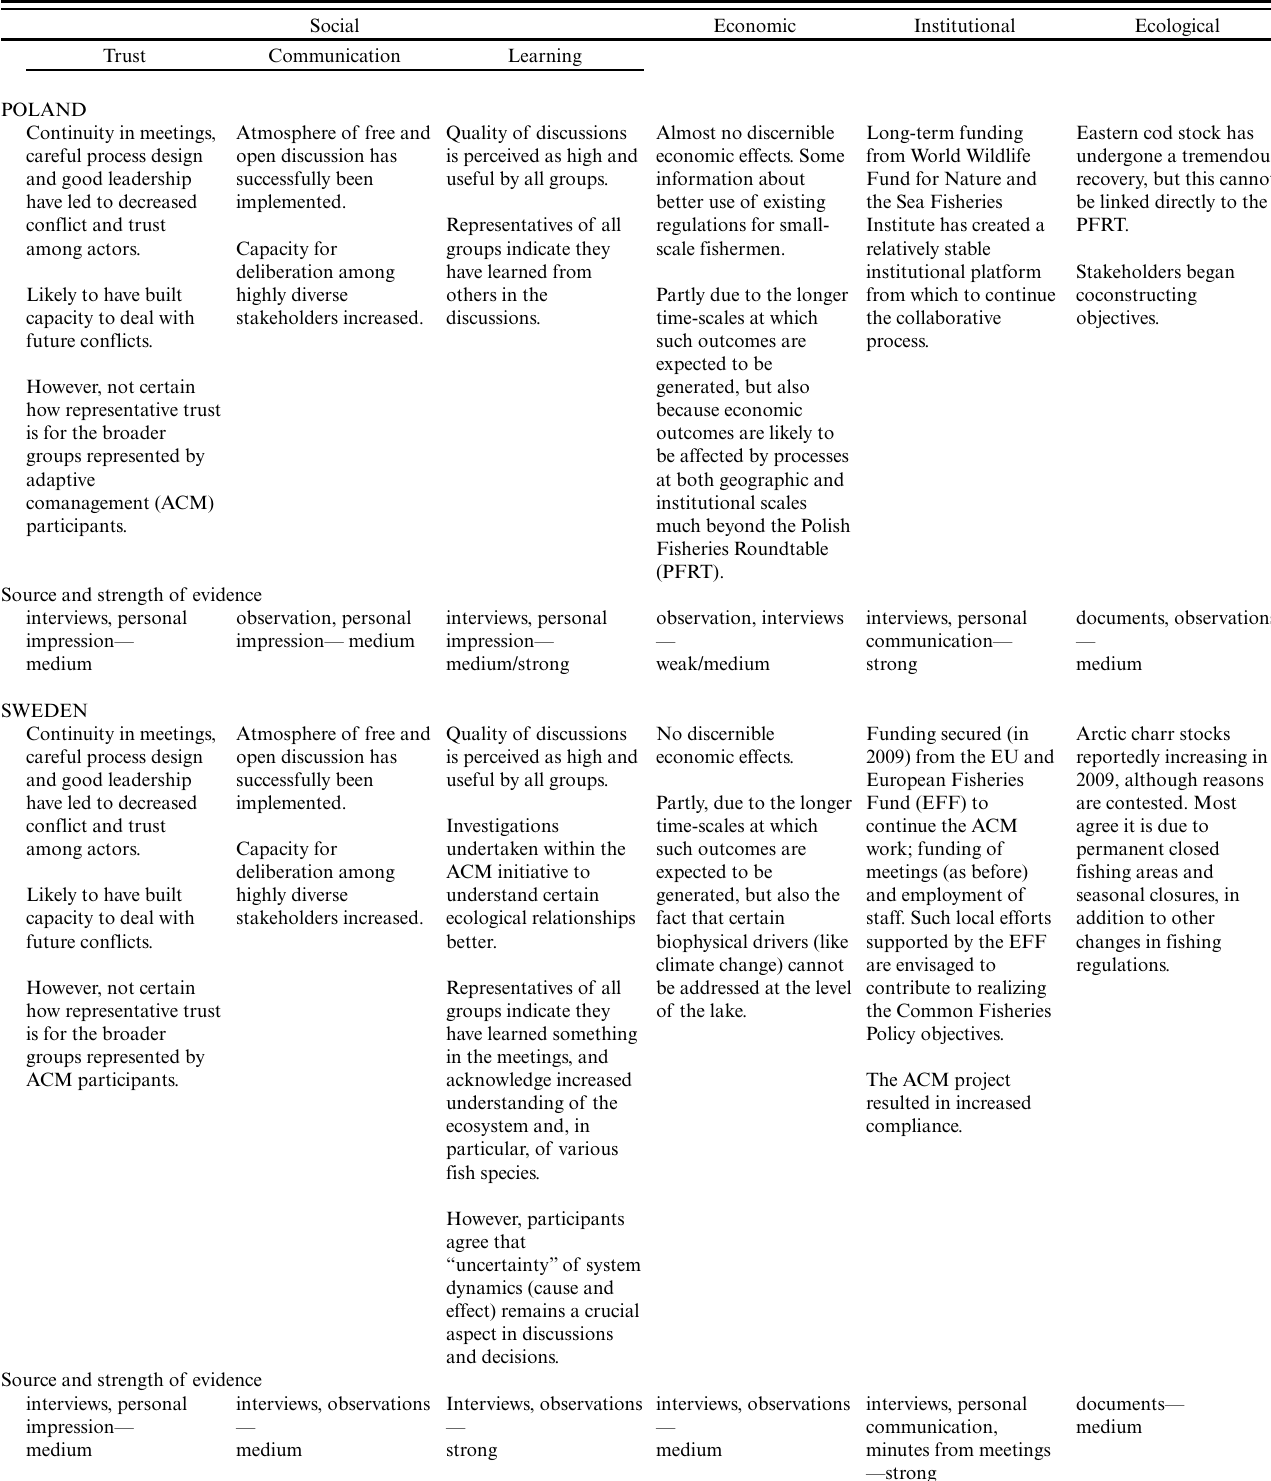
Table 3 . Outcomes of the Swedish Comanagement Initiative and the Polish Fisheries Roundtable. Social Trust Communication POLAND Continuity in